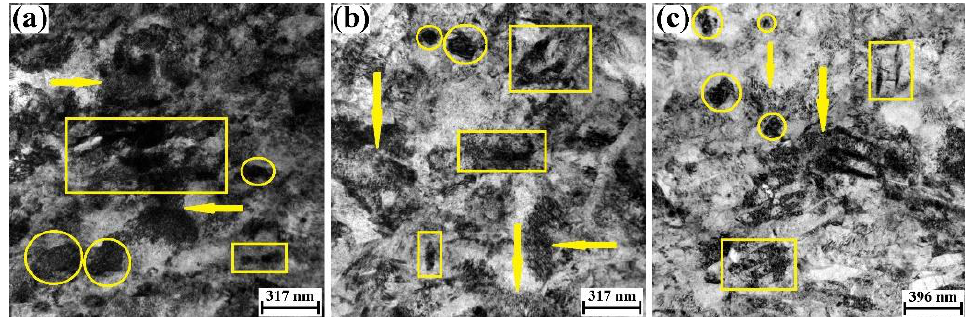
Figure 11. Microstructure of ASB for mill-annealed Ti-6Al-4V alloy plate. ( a ) TEM micrograph for ASB of RD specimen, ( b ) TEM micrograph for ASB of TD specimen, ( c ) TEM micrograph for ASB of ND specimen. The equiaxial nano- β grains, the dislocation cell of the α phase and the nano- α laminate are marked by circles, arrows and rectangles.